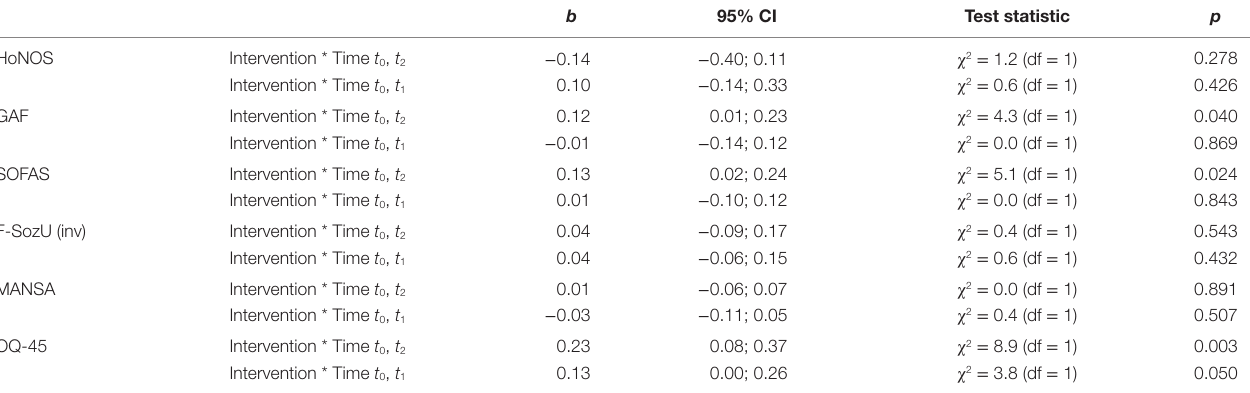
TaBlE 3 | results of a series of GEE. Control group is the reference (secondary